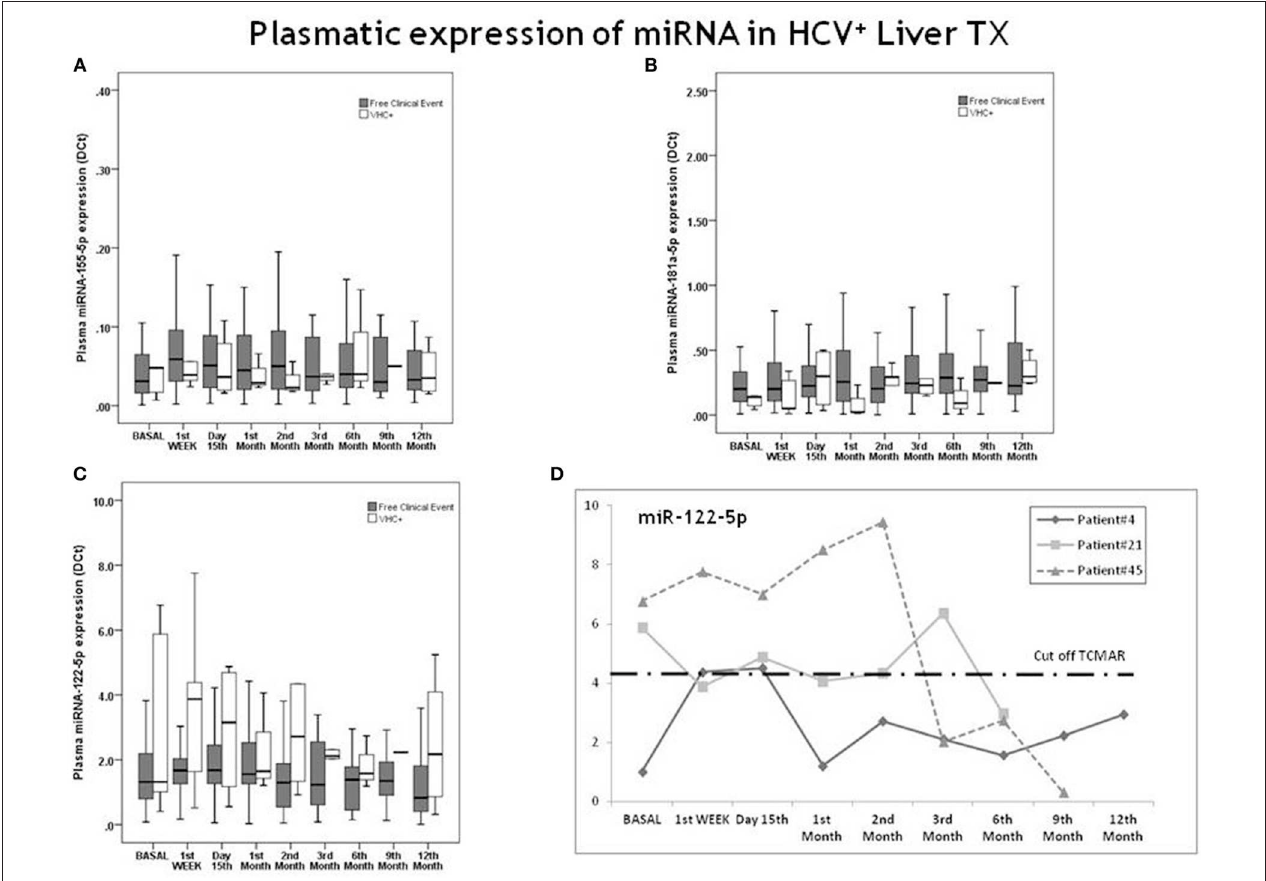
FIGURE 6 | Evolution of miR-155-5p, miR-122-5p, and miR-181a-5p expression in patients experiencing the recurrence of HCV + . Differences between patients free of any clinical event (gray boxes) and HCV + patients (white boxes) with respect to (A) miR-155-5p; (B) miR-181a-5p and (C) miR-122-5p expression during 1 year post-transplantation. Five patients developed HCV recurrence after transplantation ( n = 3 HCV RNA + patients until the 3rd month post-transplantation, with exitus occurring in one of them; one patient, until the 2nd month; and one patient, until the 6th month). Graph (D) shows the individual evolution in miR-122-5p expression in 3 patients with HCV + . The dashed horizontal line indicates the post-transplantation cut-off value for the risk of TCMAR (4.356) with respect to miR-122-5p expression.